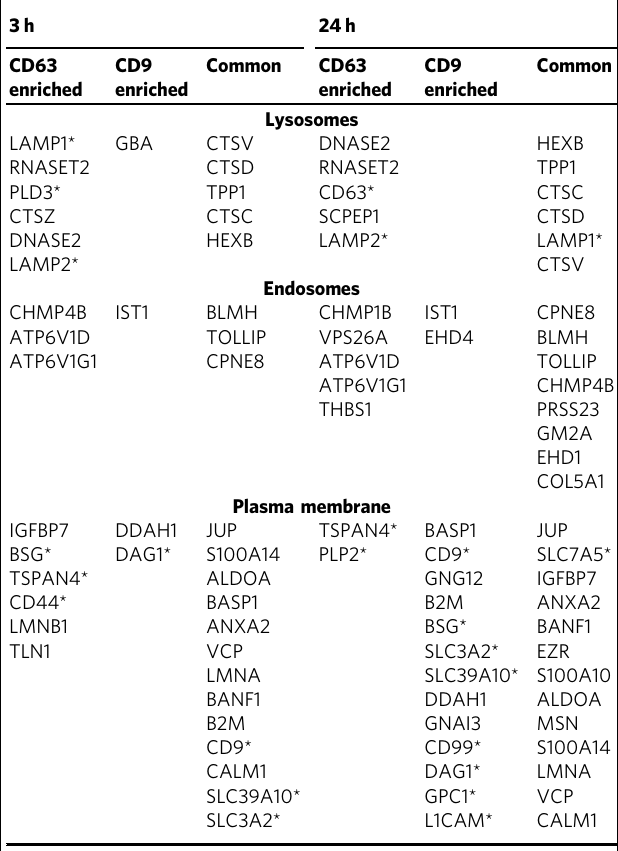
Table 1 Names of proteins identi fi ed in EVs and used for the endosome, lysosome, and PM (plasma membrane) categories are